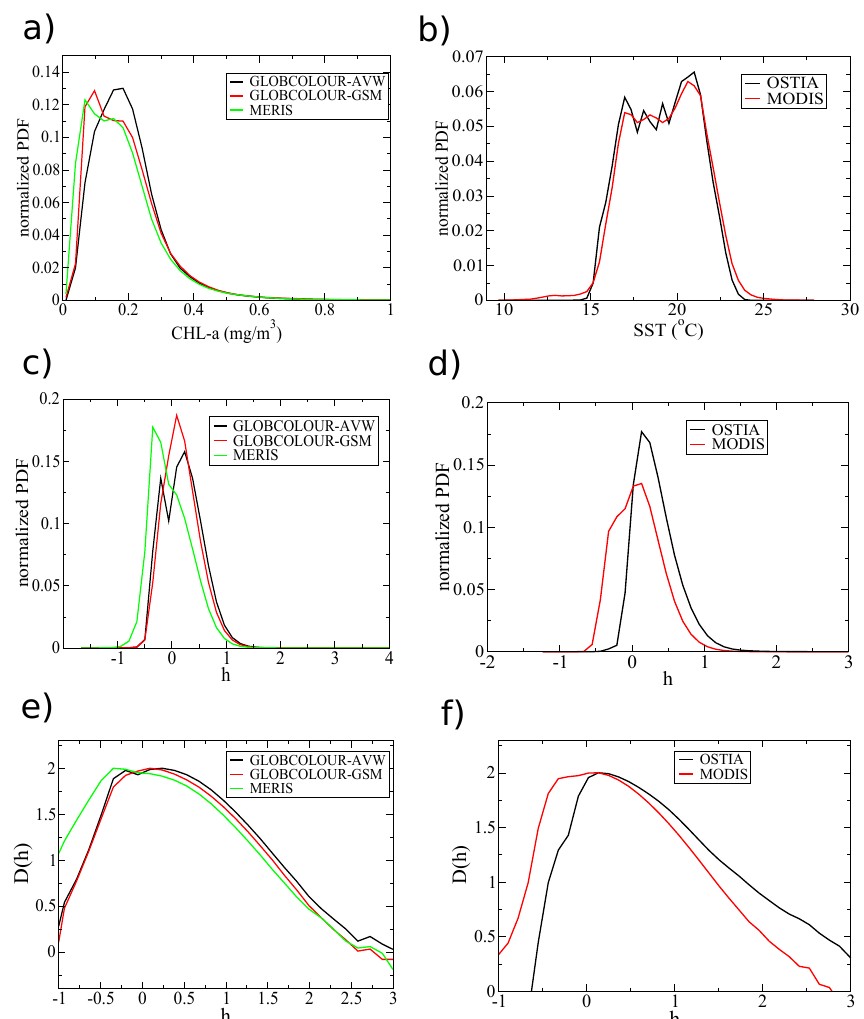
Figure 4. (a) Probability distribution functions (PDF) of Chl a values derived from the three products: MERIS, GLOBCOLOUR-AVW and GLOBCOLOUR-GSM. (b) PDF of SST values for OSTIA and MODIS products. (c) PDFs for the singularity exponents of Chl a for the different ocean color products. (d) PDFs for the singularity exponents of Chl a for the different SST products. (e) Singularity spectra corresponding to (c) . (f) Singularity spectra corresponding to (d)